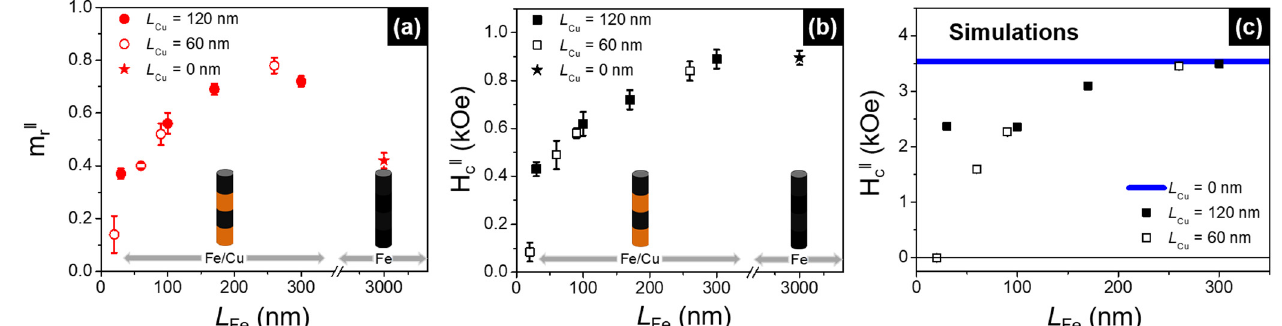
Figure 6. ( a ) Reduced remanence and ( b ) coercivity values as a function of the Fe length, measured when applying a magnetic field parallel to the wires’ long axis. ( c ) Coercive field as a function of the Fe segment length in Fe/Cu NWs with a Cu spacer length of 120 (full symbols) and 60 nm (open symbols), as well as in the 3-µm-length isolated Fe NW (blue continuous line), extracted from the simulated hysteresis loops when the external field was applied parallel to the NW’s longitudinal axis.